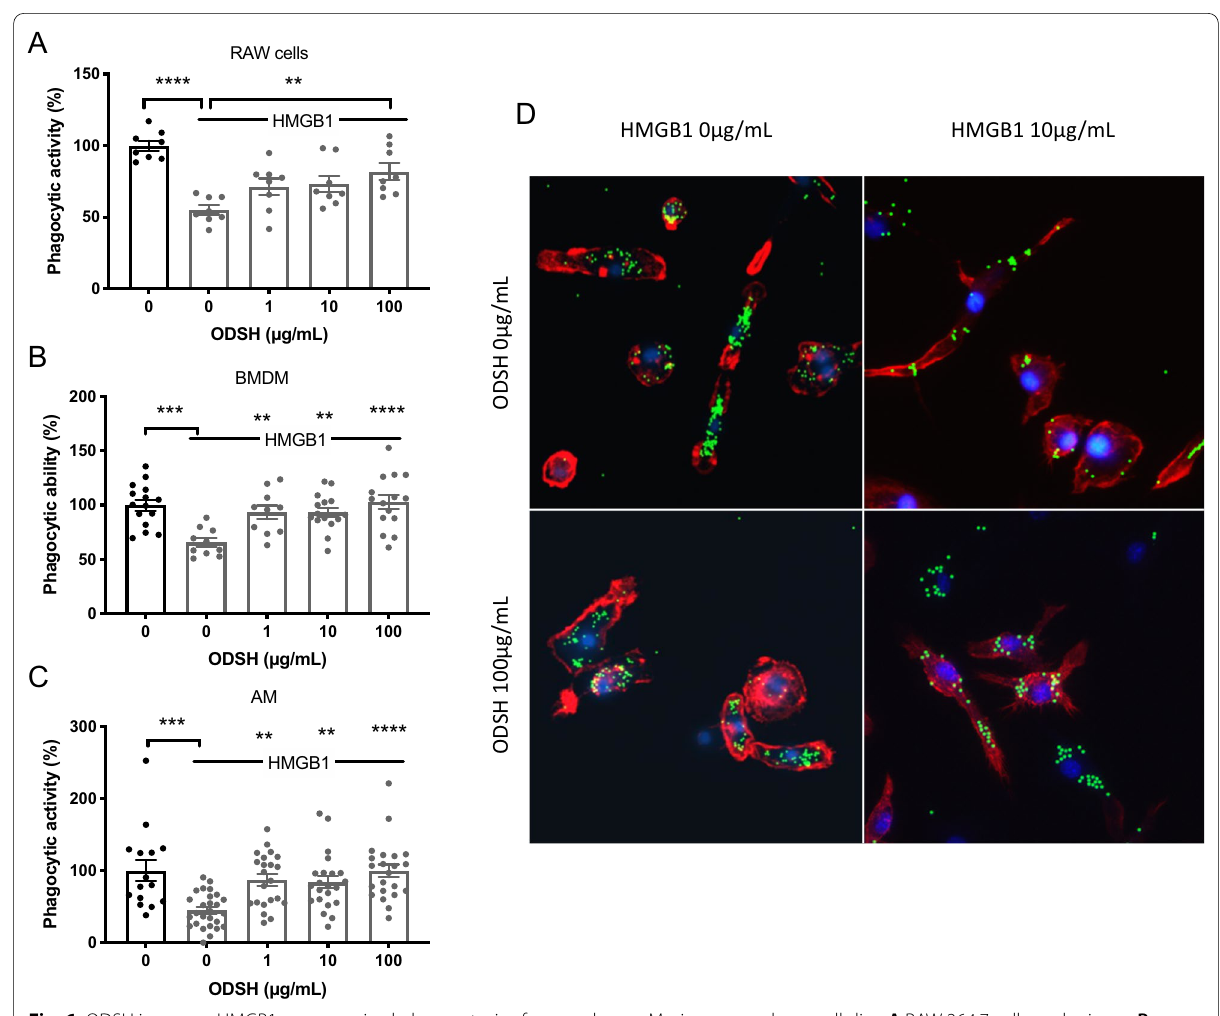
Fig. 6 ODSH improves HMGB1-compromised phagocytosis of macrophages. Murine macrophage cells line A RAW 264.7 cells, and primary B bone-marrow derived macrophages (BMDMs), and C alveolar macrophages (AM) isolated from CFTR −/− mice (CF, n recombinant HMGB1 (10 µg/mL) without or with co-treatment with ODSH at 1, 10, 100 µg/mL for 24 h. Phagocytosis assay was performed on the macrophages by incubating with FITC-labeled latex mini-beads (green stain) for 1 h and then staining with DAPI (blue nuclear stain) and phalloidin (red cytoskeletal stain) to visualize the amount of phagocytosed beads per cell. Fluorescent micrographs were quantified, and the phagocytic ability of macrophages was represented as a percent phagocytic activity normalized to WT control group. D Represented images of macrophage phagocytosis under different conditions. One-way ANOVA was used for multiple group comparison. Each value represents mean independent experiments for each group. **, P < 0.01, ***, P < 0.001, ****, P < 0.0001 compared to control